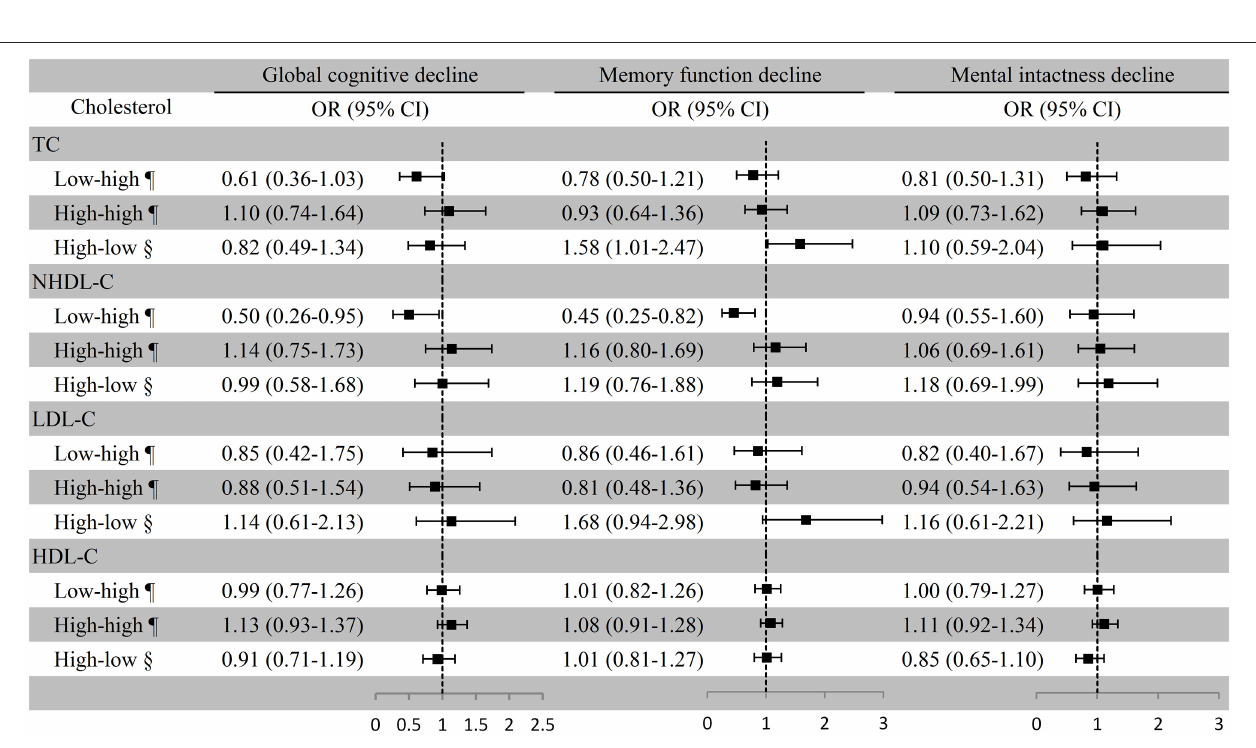
Frontiers in Aging Neuroscience | www.frontiersin.org